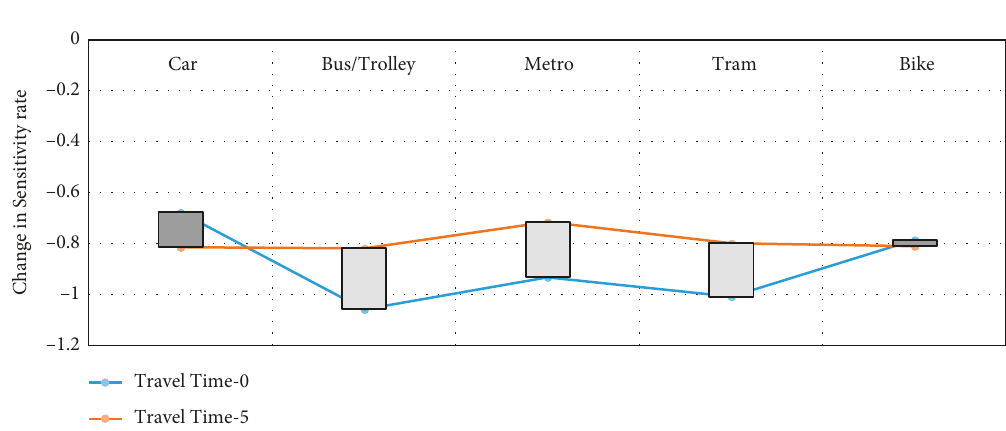
Figure 4: A comparison of the coefficients of the mode choice based on changing the travel